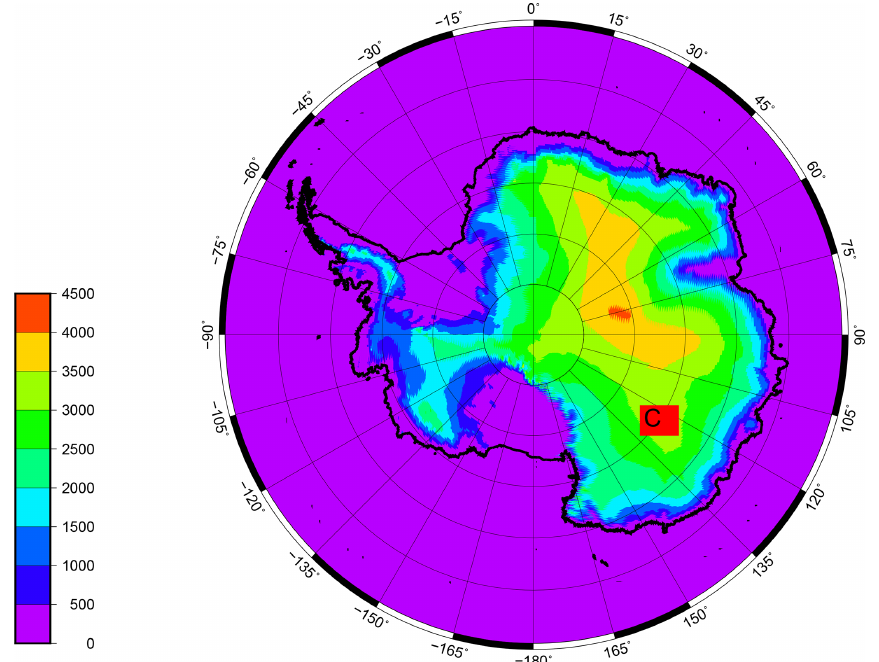
Figure 1. Antarctic map showing topography (color scale, in m) and position of Dome C or Concordia station